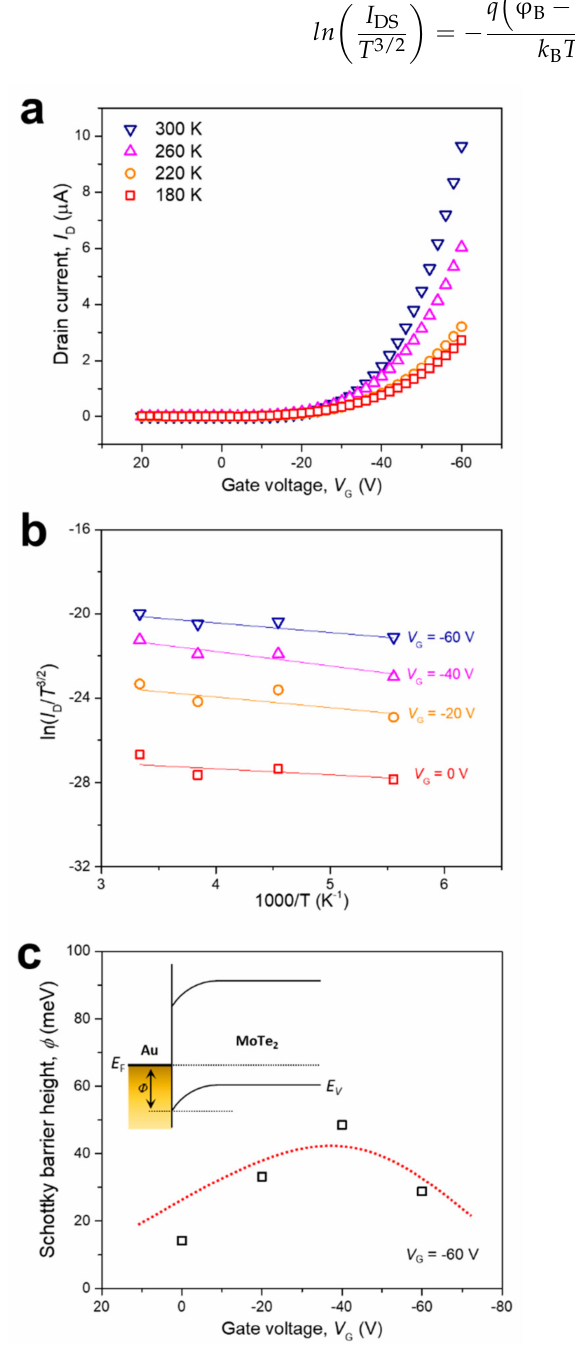
Figure 4. Transfer curves and Schottky barrier of 1T (cid:48) MoTe 2 FETs at various temperatures: ( a ) Transfer curves obtained from laser-irradiated 1T (cid:48) MoTe 2 FETs at temperatures ranging from 180 to 300 K; ( b ) Arrhenius plot of laser-irradiated 1T (cid:48) MoTe 2 FETs with gate voltages ranging from 0 V to − 60 V; ( c ) Schottky barrier height of laser-irradiated 1T (cid:48) MoTe 2 FETs. The inset shows the schematic of the Schottky barrier of p -type MoTe 2 with contact to the Au